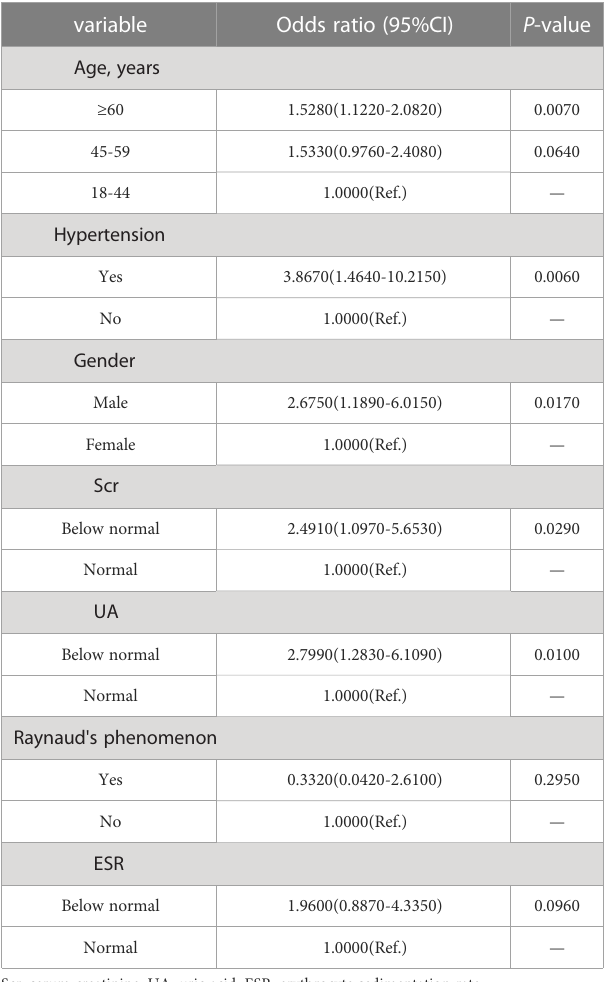
TABLE 2 Univariate logistic regression for features of diabetes